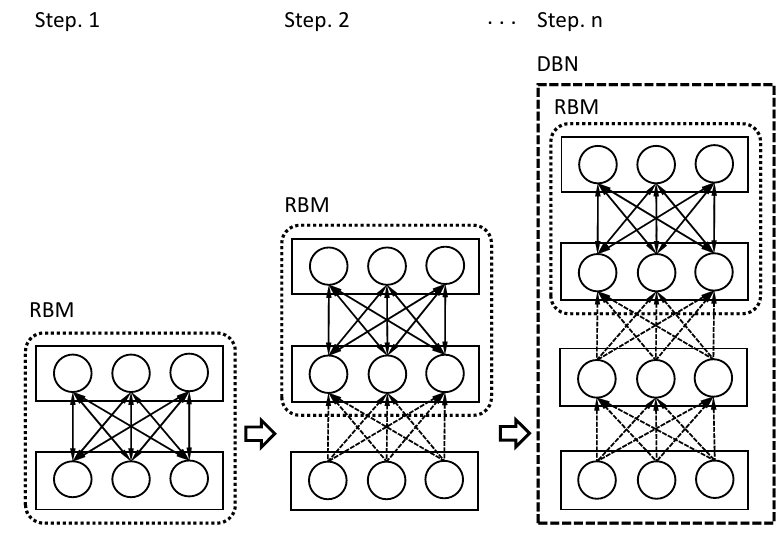
Figure 3. Stacking RBM.